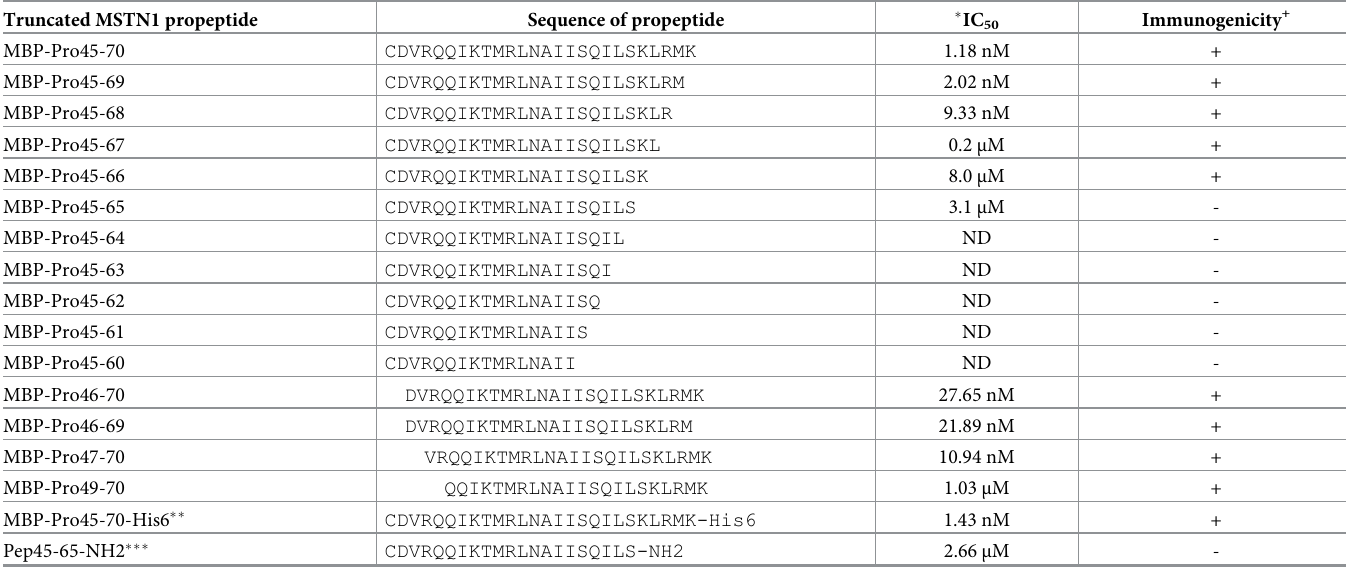
Table 1. The inhibition of MSTN activity by MBP-fused, truncated MSTN1 propeptides of flatfish and immunogenicity of the truncated MSTN1 propeptides. Truncated MSTN1